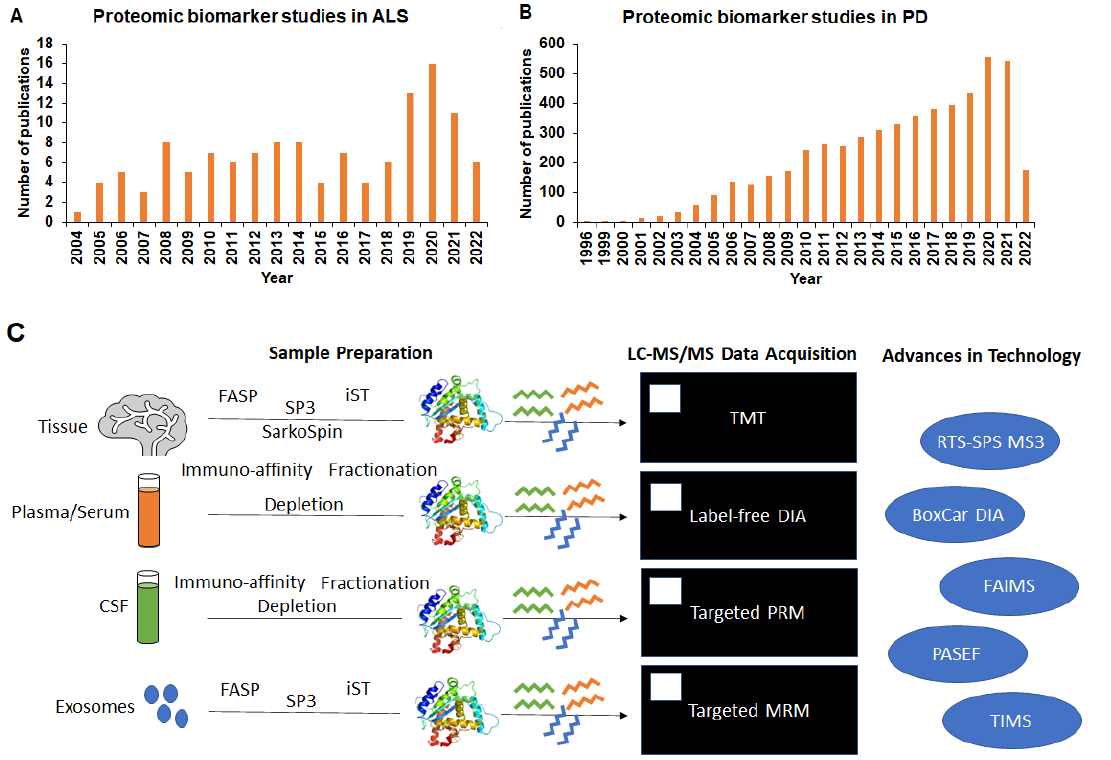
Figure 1. Summary of the number of proteomic biomarker studies in ( A ) ALS and ( B ) PD. ( C ) Schematic of proteomics workflow and advances in mass spectrometry instrumentation for biomarker discovery.